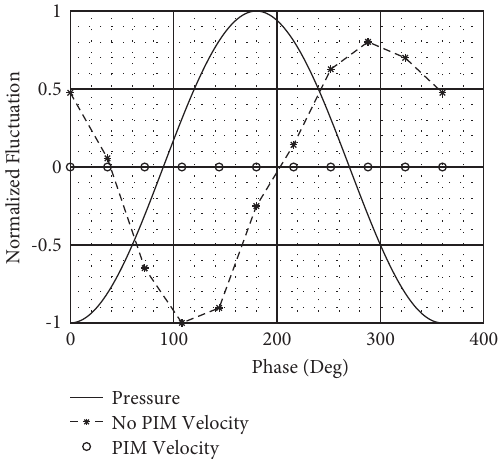
Figure 12: Normalized acoustic pressure, phased averaged velocity without and with PIM as a function of phase angle of the Instability frequency.